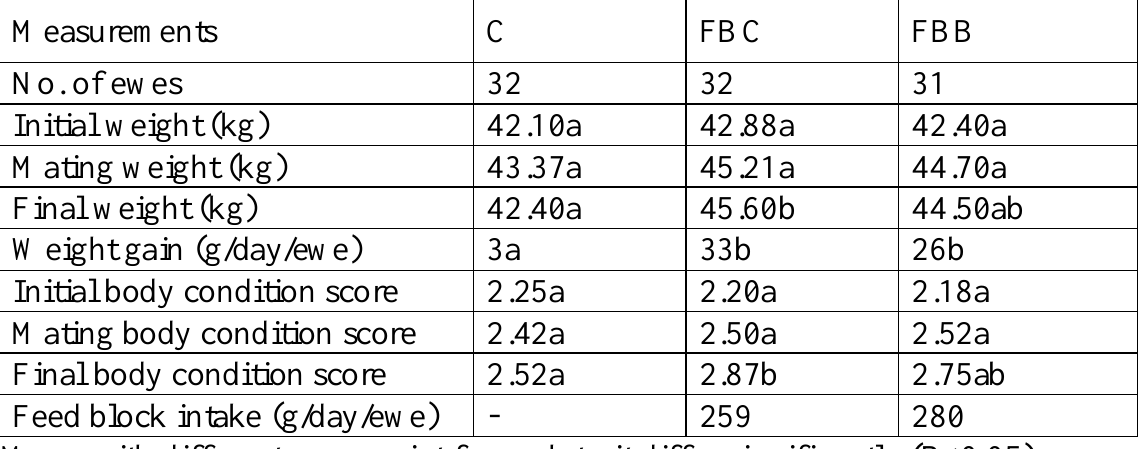
Table 3: Effect of feed block supplementation on weight, weight changes and body condition score of Awassi ewes grazing cereal